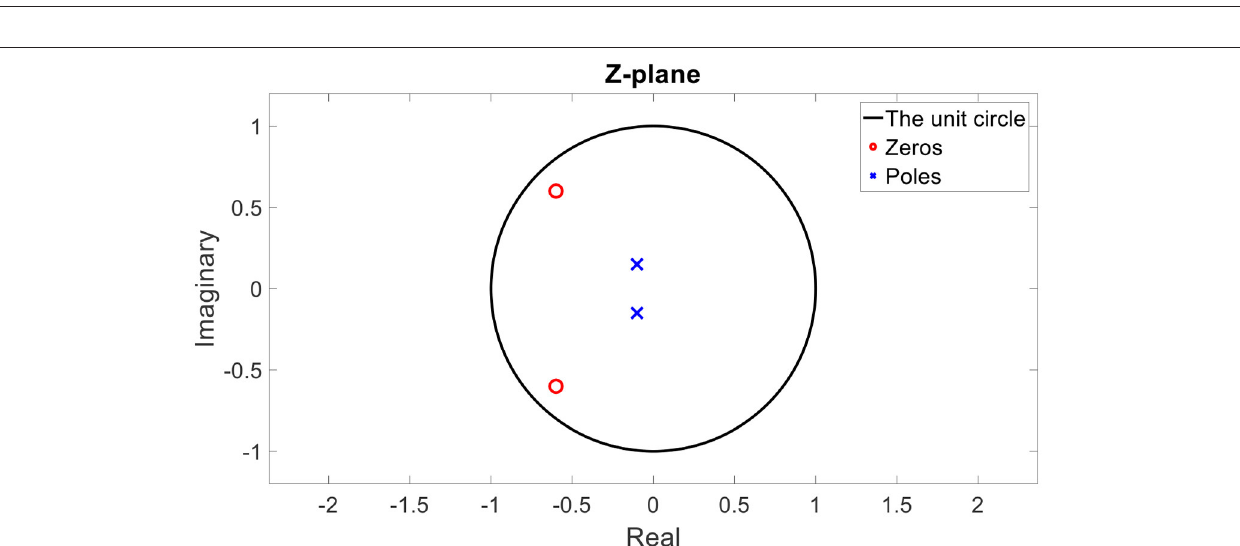
FIGURE 3 | An example of the poles and zeros of a minimum phase transfer function in a Z-plane (after Z transform).